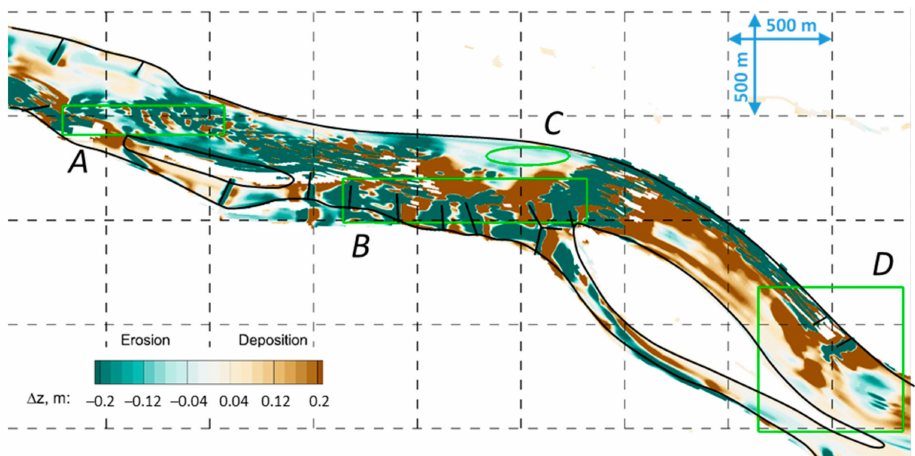
Figure 9. Calculated bed changes by the vR formula for the historical flood wave (Figure 3).